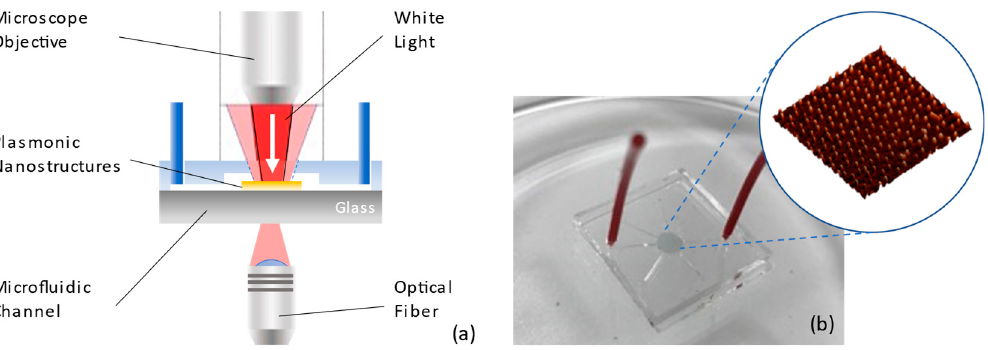
Figure 8. ( a ) Schematic representation of the experimental setup used to perform optical measurements in liquid environment and transmission configuration; ( b ) picture of the miniaturized lab-on-a-chip (LOC) platform based on the integration of nano-structured LSPR transducers into a 2.5 cm × 2.5 cm PDMS microfluidic chip.